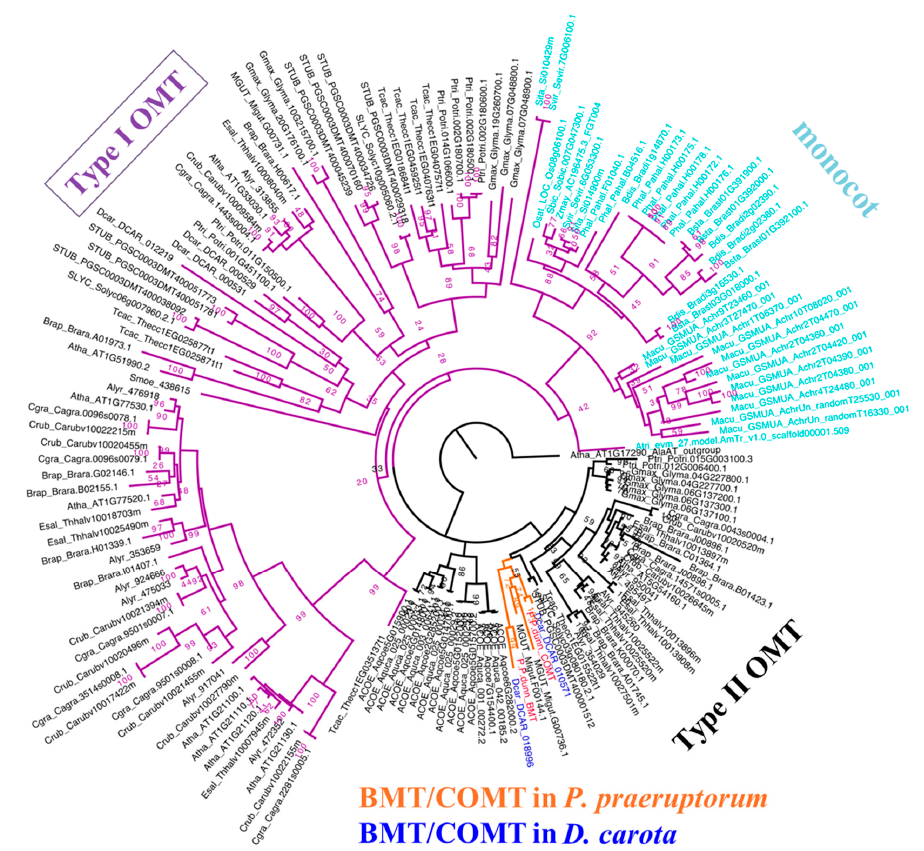
Figure 7. The evolution of BMT and COMT-S. There are two types of OMT in higher plants, type I OMTs (purple branch) present both in monocot (light blue leaves) and dicot (black leaves), and type II OMTs (black branch) exist only in dicot. BMT and COMT-S are both found in P. praeruptorum (red leaves) and D. carota (blue leaves), the two species of which belong to Asterids (orange branch).